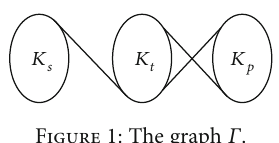
Figure 1: The graph Γ